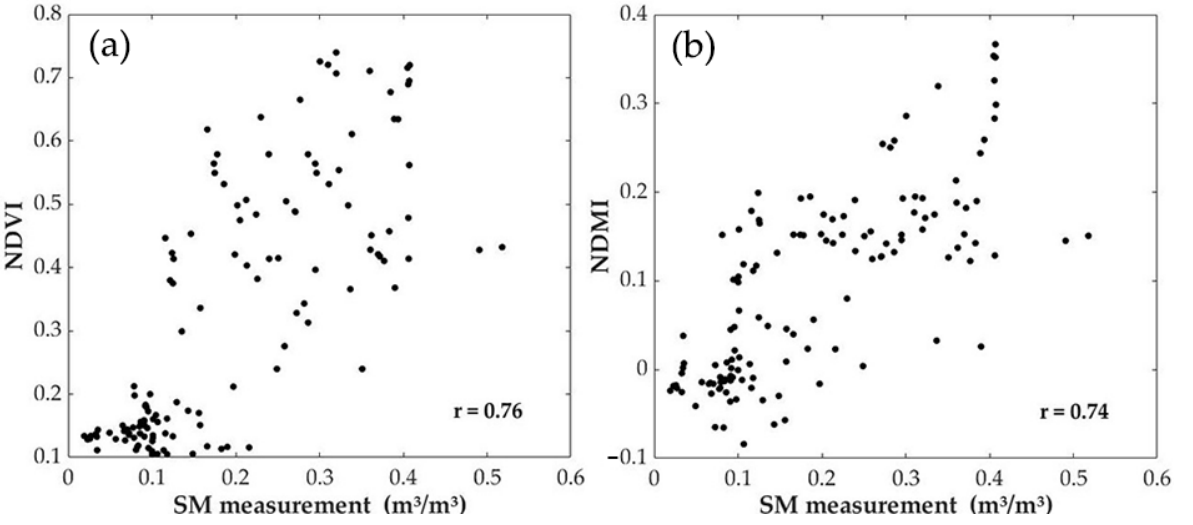
Figure 6. Relationship between the vegetation parameters and the SM measurements at the site. ( a ): NDVI and SM; ( b ): NDMI and SM.